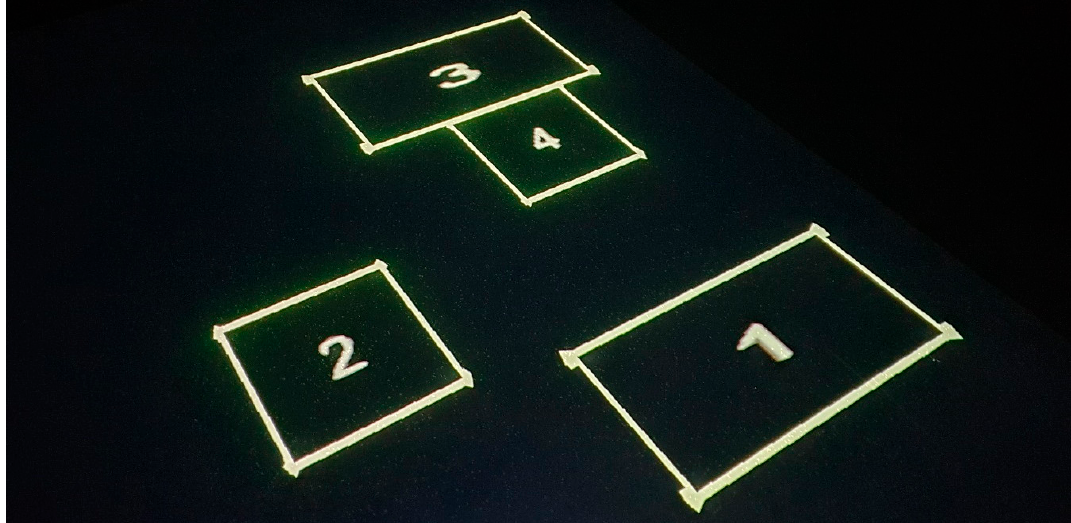
Figure 3. The outlines of four rectangular prisms, as shown top-down from the projector. This layout/scene is used for subsequent